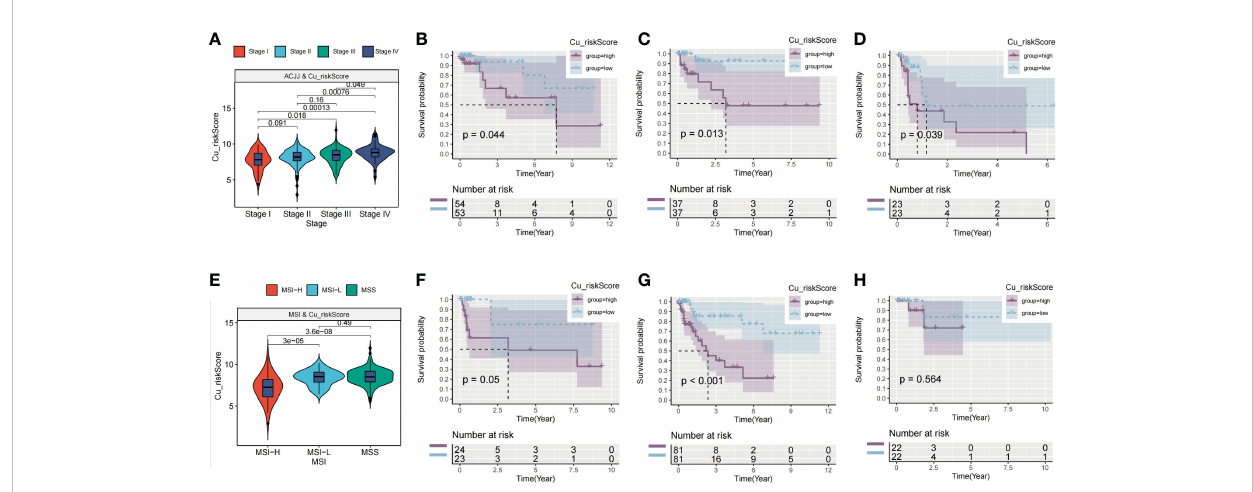
FIGURE 3 Clinical value of Cu_riskScore. (A) Cu_riskScore levels in four different stages in TCGA. (B – D) Kaplan-Meier survival analysis of the Cu_riskScore high group and Cu_riskScore low group in stage II, stage III, and stage IV, respectively. (E) Cu_riskScore levels in three different MSI types. (F – H) Kaplan- Meier survival analysis of the Cu_riskScore high group and Cu_riskScore low group in MSI-L, MSS, and MSI-H,